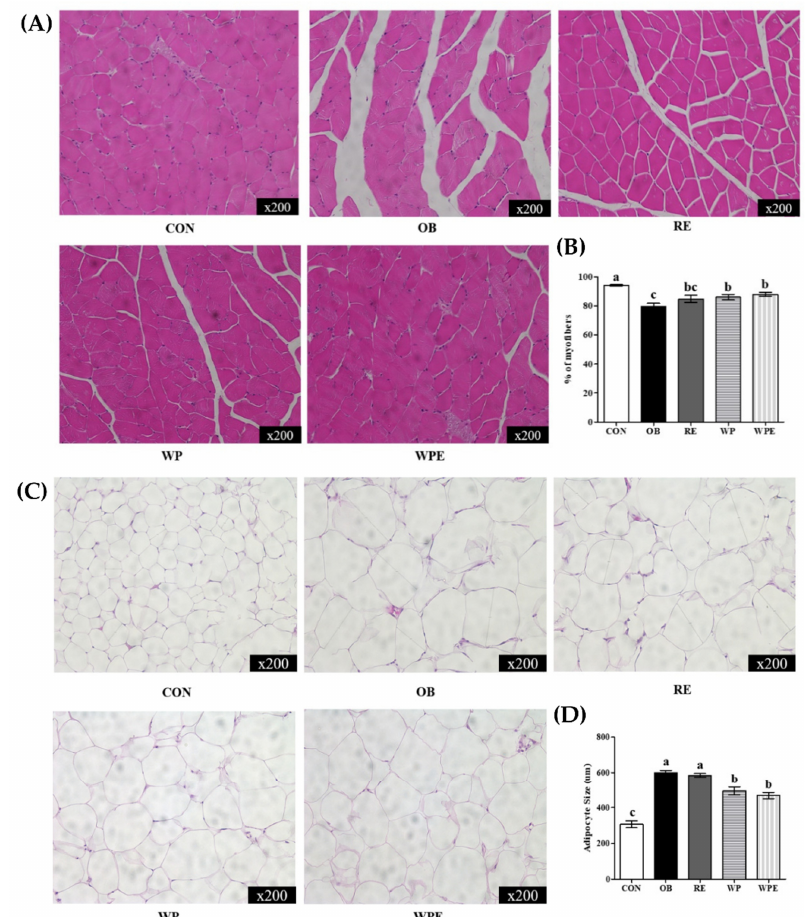
Figure 3. Effects of WP supplementation and RE on adipose tissue and skeletal muscle morphology (×200) in sarcopenic obese mice. ( A ) Adipose tissue morphology, ( B ) Mean adipocytes size (um), ( C ) Gastrocnemius morphology, and ( D ) Mean myofibers area (%). Values are means ± SEMs, n = 3–4. Mean values with the same superscript letter (a,b and c) are not significantly different ( p < 0.05).